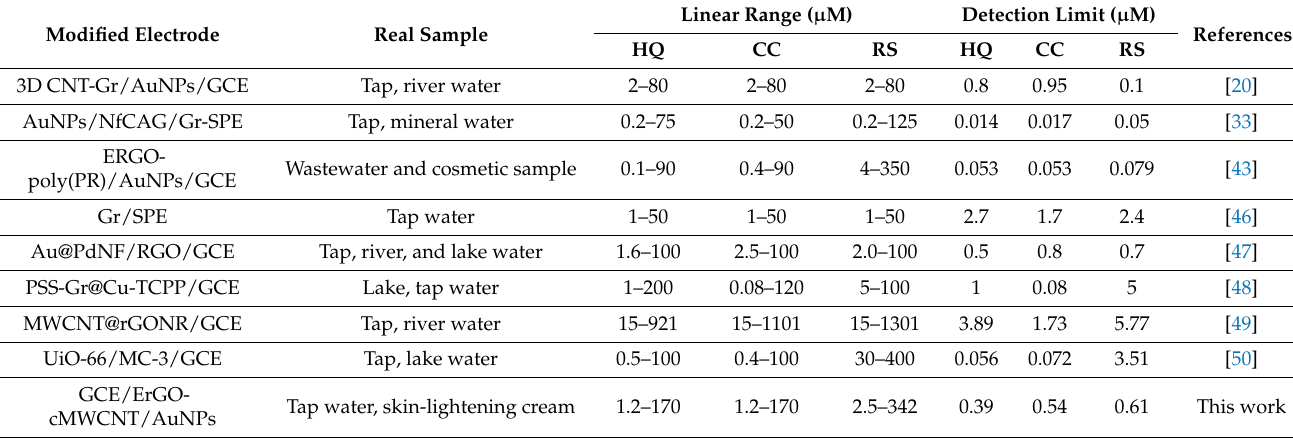
Table 2. Comparison of similar methods for the simultaneous determination of HQ, CC, and RS. Modified